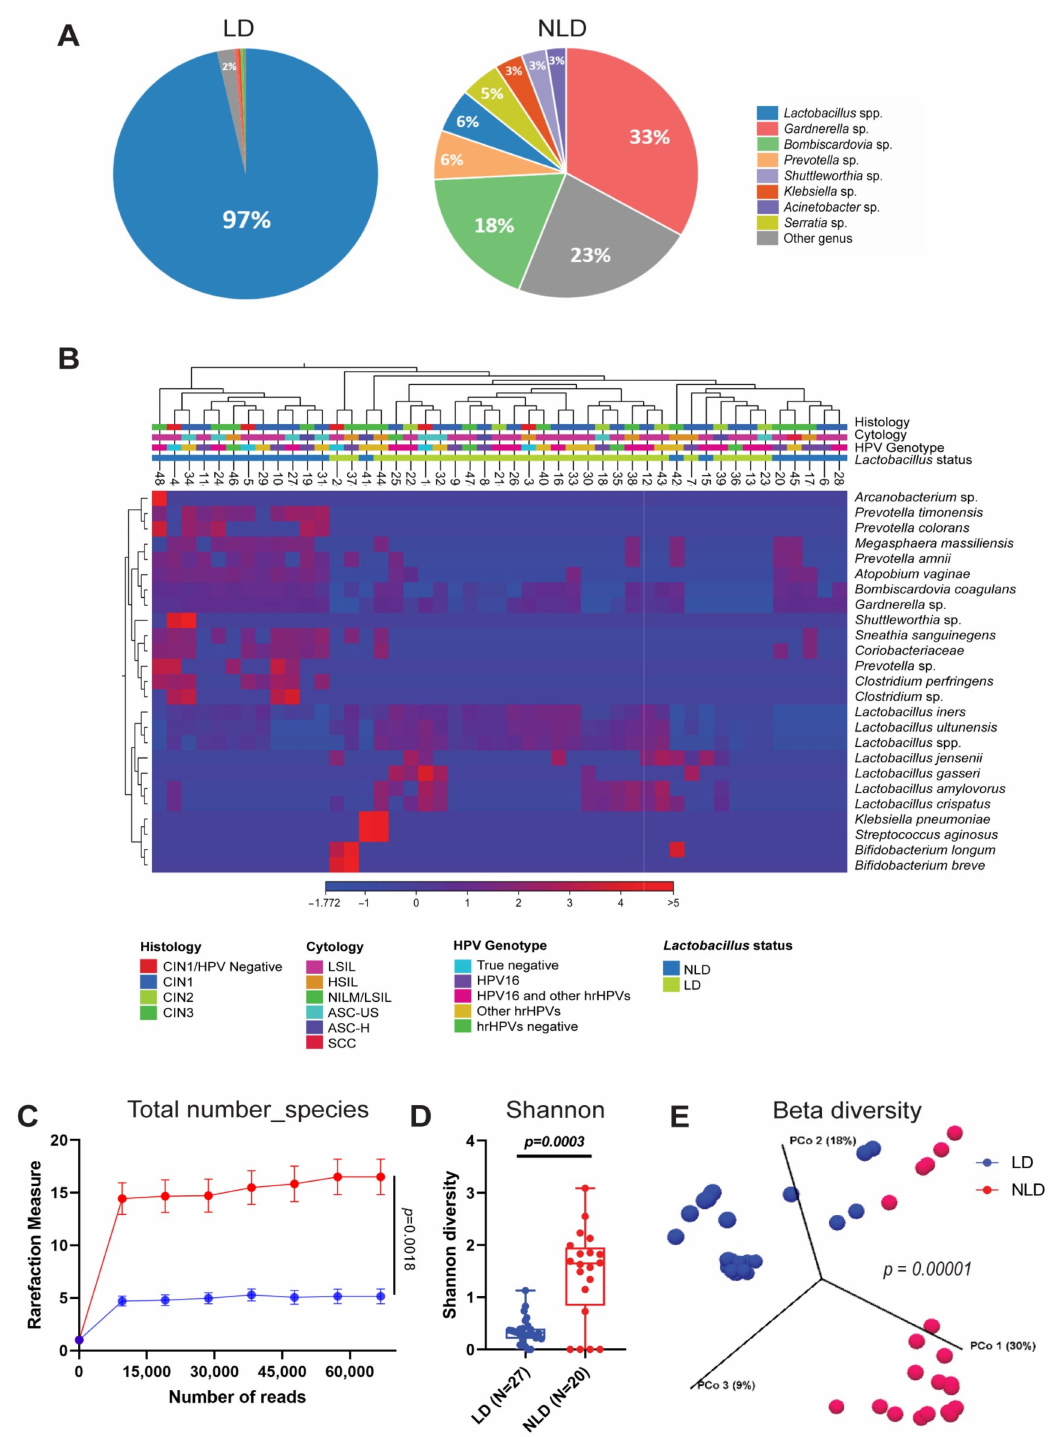
Figure 1. The composition of bacterial community in cervical samples. ( A ) The percentage of the top 8 bacterial genera found in the cervix. ( B ) The hierarchical clustering tree and heat map of bacterial taxa were generated using UPGMA and Euclidean as the algorithm and similarity index, respectively. The color key under the tree represents histology, cytology, HPV genotypes, and Lactobacillus status. Blue to red color shades represent increasing relative abundance. ( C ) α -diversity, total number of species, ( D ) α -diversity, Shannon diversity index, and ( E ) β -diversity. Error bars represent the standard error of the mean (SEM). Blue = LD, Red =